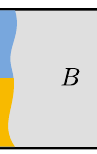
= N = 0.5 N ρ T 2 is A 2 A . A general form of the spectral density of 1